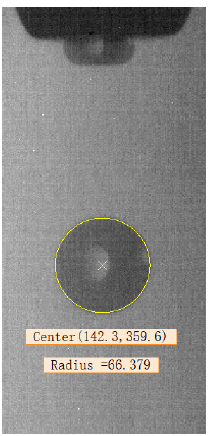
Figure 12. Center coordinates and radius of the droplet (unit: pixel).